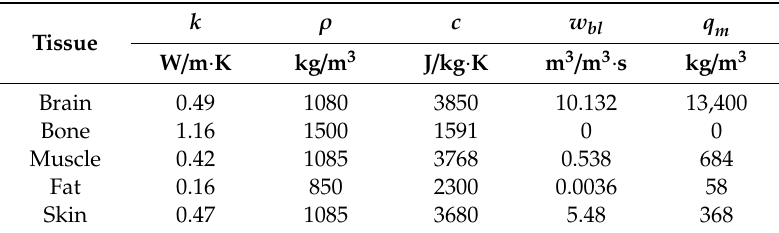
Table 1. Physical and thermal properties of di ff erent tissue [35].